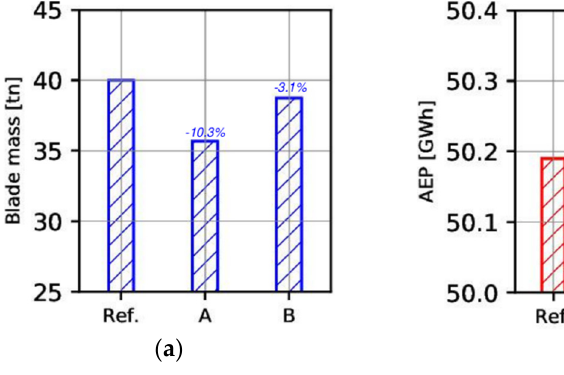
Figure 8. Structural twist distribution of the design configurations. 3.3. Combined Application of Passive Control Methods—CASES C, D and E In the present section, CASES C, D and E, in which combined application of different passive load control methods is performed, are addressed. In CASE C, combined application of the two FEC methods (material and geometric) is performed. Figures 9 and 10 provide the radial distributions of the material thickness coefficients and of the caps’ displacement, respectively, for CASE C and all other config- urations analysed. It is seen that the combined application of the two methods does not significantly alter the design parameters of the material FEC. On the other hand, the radial distributions of the caps’ displacement appear to be much more sensitive (see Figure 10). This is justified by the observation made in Section 3.2 that the material FEC is far more effective in adjusting the structural twist. Thus, while the predominant design variable that affects structural twist exhibits similar behaviour with that of CASE A, the secondary parameter, which only has an additive effect, is let free by the optimizer to vary a lot more (i.e., the optimum is rather flat). It is interesting to note that, in particular in CASE C, the optimizer finds that the optimum displacement for the H/P cap is towards the LE, while the L/P cap remains almost un-displaced. Although this seems to be a paradox on first reading, it is explained by the fact that moving the H/P cap towards the leading edge leads to an increase in the H/P “trailing” element, leaving more space for material FEC to adjust the cross-bending stiffness. The reduction in the mass achieved by CASE C is 13.3%, which is, more or less, the summation of the reductions achieved in CASES A and B. The reduc- tion in the LCoE in CASE C is 1.02%, slightly lower than the sum of the reductions attained